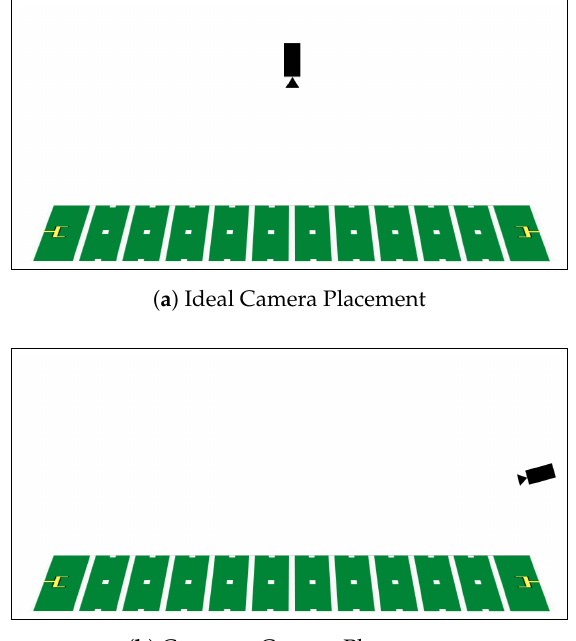
Figure 1. The camera placement ( a ) shows that the ideal location of the camera is in a position where all of the players are directly visible and no occlusion occurs; ( b ) shows a common placement of the camera that captures football footage is at the edge of the field, causing player